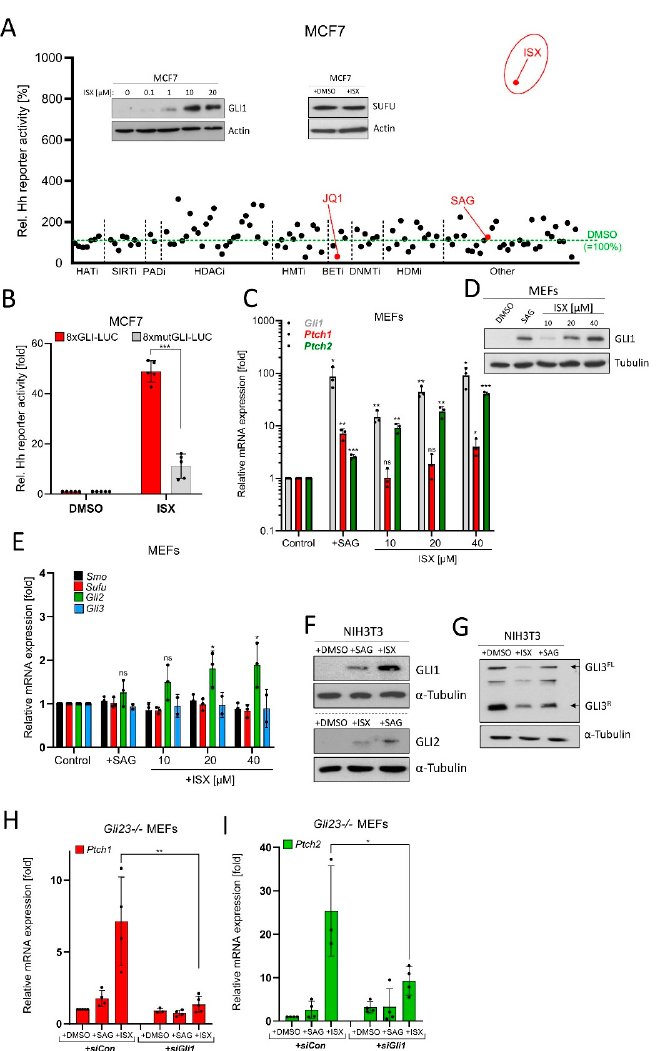
Figure 3. Identification of a small molecule GLI1 inducer. ( A ) Epigenetic drug screen in MCF7 cells transiently transfected with 8xGLI-Luc reporter plasmid and treated with compounds for 24 h. Shown are mean values of n = 3 relative to DMSO treatment (=100%). HATi: Histone acetyl transferase inhibitors; SIRTi: Sirtuin inhibitors; PADi: Protein arginine deiminase inhibitors; HDACi: Histone deacetylase inhibitors; HMTi: Histone methyl transferase inhibitors; BETi: BET-domain inhibitors; DNMTi: DNA methyl transferase inhibitors; HDMi: Histone demethylase inhibitors. See Supplementary Materials Section for more details. The insets depict Western blots of MCF7 cell lysates after treatment with DMSO or ISX (48 h) as indicated. In the SUFU blot experiment and in the screen, ISX was used at a concentration of 20 µ M. ( B ) Luminometric Hh reporter assay in MCF7 transiently transfected with 8xGLI-Luc or mutated 8xGLI-Luc construct. Cells were treated with DMSO or 20 µ M ISX for 24 h. Shown is the mean of n = 5 ± SD. ( C ) Hh target gene expression ( Gli1, Ptch1, Ptch2 ) in mouse embryonic fibroblasts (MEFs) treated for 48 h as measured by qPCR. SAG: 100 nM. Mean of n = 3 ± SD. ( D ) GLI1 Western blot of MEF lysates. Treatment as indicated; SAG: 100 nM. One representative experiment of two. ( E ) Hh pathway gene expression ( Smo, Sufu, Gli2, Gli3 ) in mouse embryonic fibroblasts (MEFs) treated for 48 h as measured by qPCR. SAG: 100 nM. Mean of n = 3 ± SD. ( F ) Western blot depicting GLI1 and GLI2 protein levels in treated (ISX 20 µ M; SAG 100 nM; 48 h) NIH3T3 cells. Shown is one representative experiment of n = 3. ( G ) Western blot depicting GLI3 protein levels in treated (ISX 20 µ M; SAG 100 nM; 48 h) NIH3T3 cells. GLI3 FL : Full-length GLI3; GLI3 R : Repressor form of GLI3. Shown is one representative experiment of n = 3. ( H ) Quantitative PCR measuring expression of the Hh target gene Ptch1 in Gli23-/- MEFs. Treatment with ISX (20 µ M) or SAG (100 nM) for 48 h. Cells were transfected with control siRNA (siCon) or an equimolar pool of three Gli1 -specific siRNAs (siGli1). Mean of n = 4 ± SD. ( I ) Quantitative PCR measuring expression of the Hh target gene Ptch2 in Gli23-/- MEFs. Treatment with ISX (20 µ M) or SAG (100 nM) for 48 h. Cells were transfected with control siRNA (siCon) or an equimolar pool of three Gli1 -specific siRNA (siGli1). Mean of n = 4 ± SD. Significances were indicated as ns (not significant; p > 0.05), * p < 0.05, ** p < 0.01, *** p <